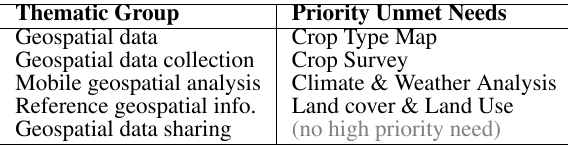
Table 1. Priority unmet needs by thematic